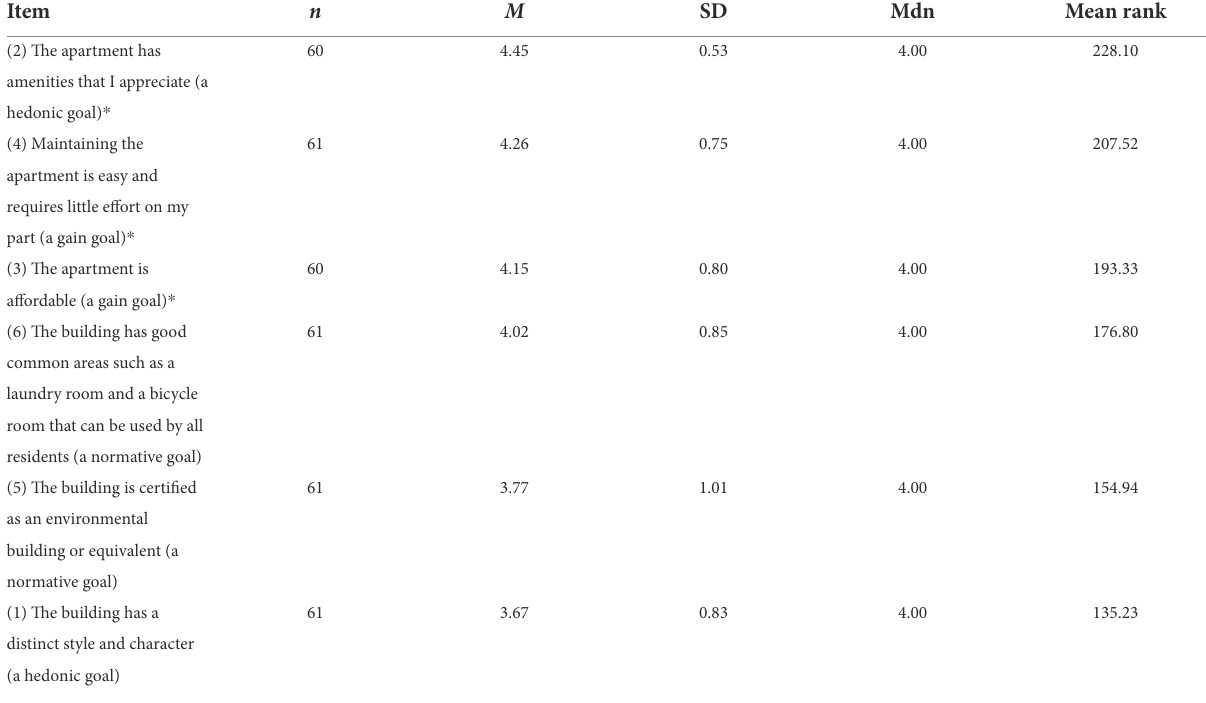
TABLE 1 Mean and median importance scores, and mean rank, for the six items included in the questionnaire for building end-users.